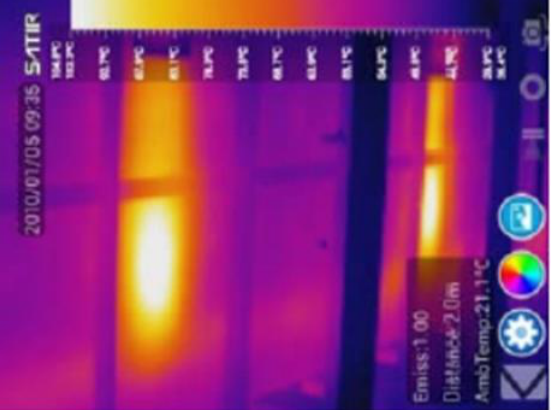
Figure 8. Cooling zone of the continuous kiln of unit two before any improvement (source: Energy Audit Report 2018).